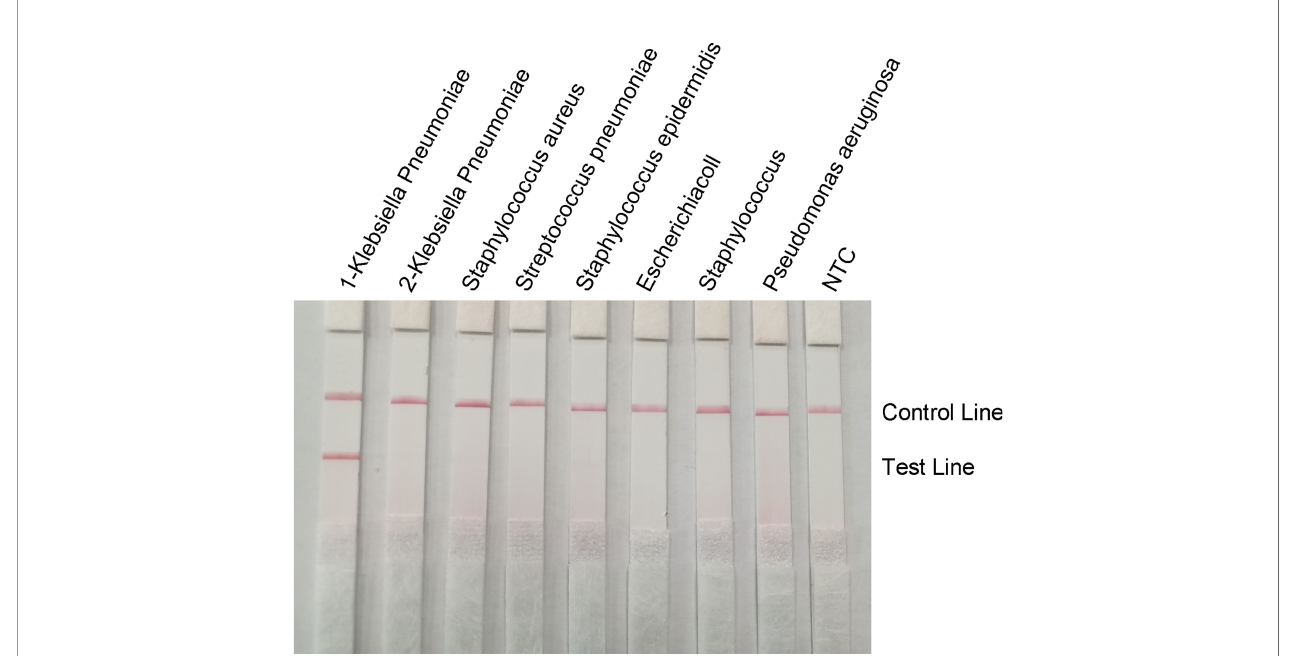
FIGURE 8 | Speci fi city of the RPA-LFS system. The bacterial species is shown at the top of each strip. The NTC strip is a no-template control. The reaction was performed at 37°C for 30 minutes. The positions of the control and test lines are shown on the right side of the image. 1-Klebsiella pneumoniae means carrying rmpA2, 2-Klebsiella pneumoniae means not carrying